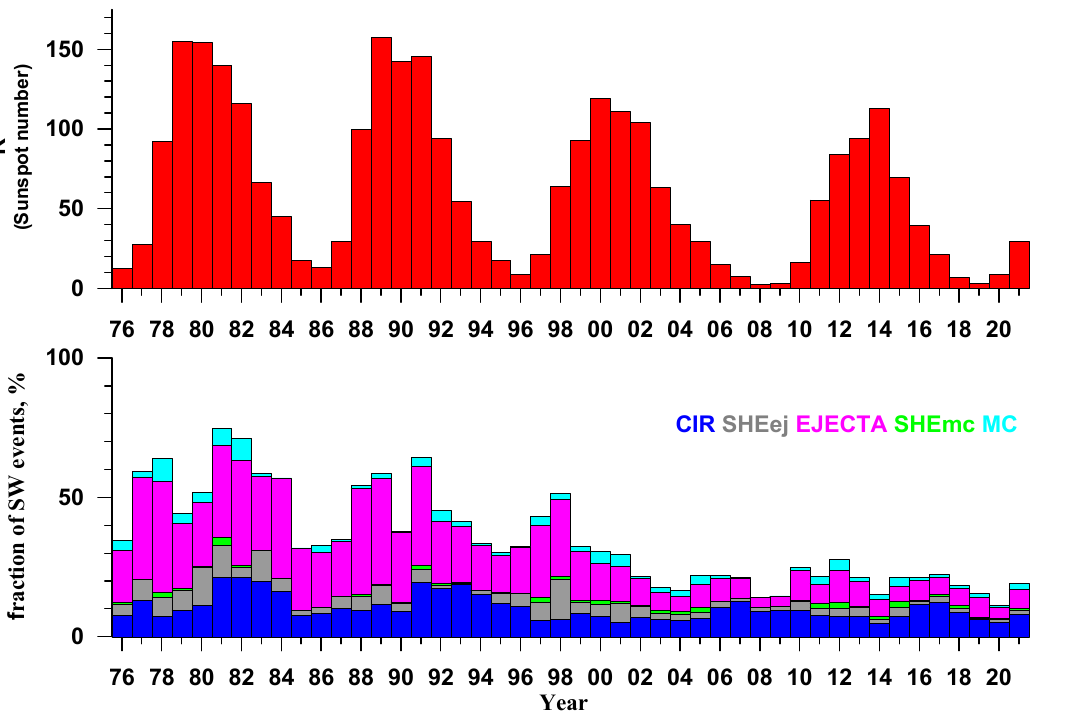
Figure 1. Yearly number of sunspots (upper panel) and fractions of disturbed SW events (bottom panel; legend is shown on the panel) during the period of 1976–2021.